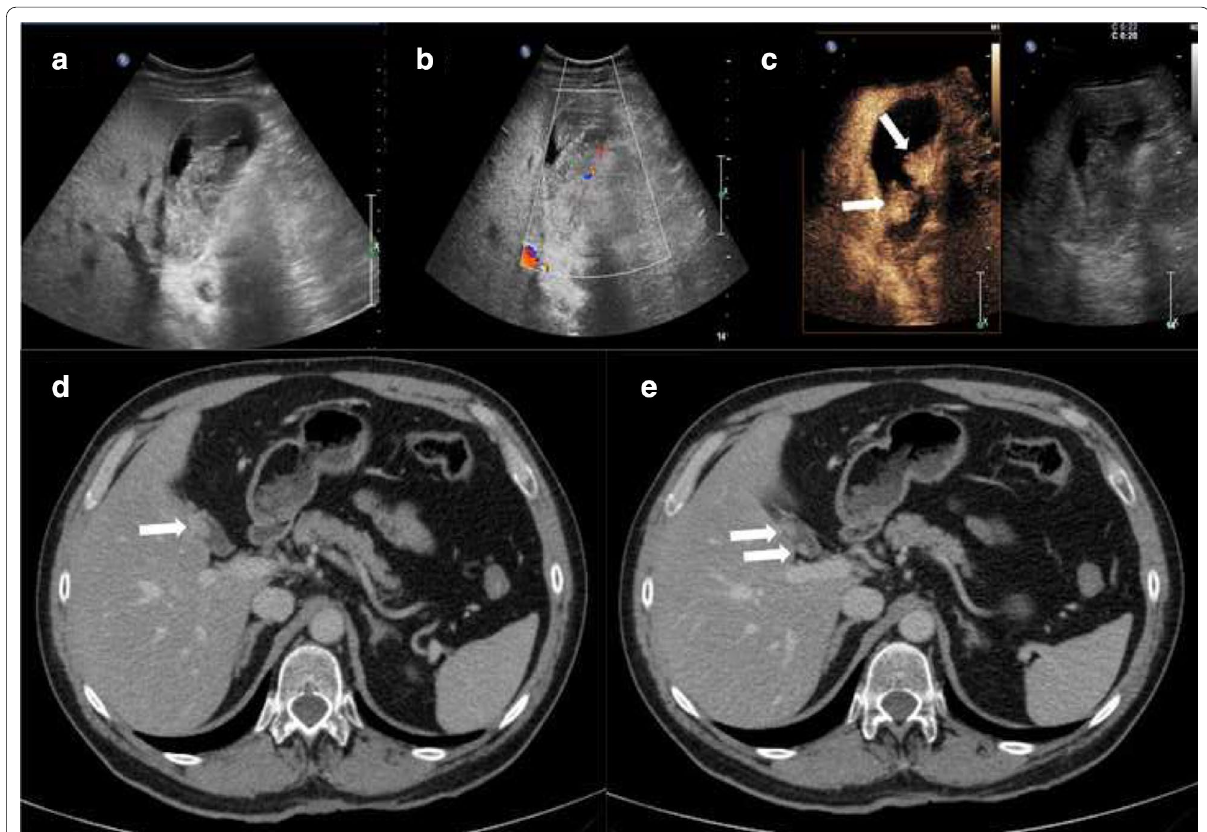
Fig. 1 A 56-year-old male hospitalized for right upper abdominal pain with nausea and vomiting. The pain was irradiated to the right scapular region. His medical history included a total excision of dorsal melanoma 2 years before, with no evidence of metastatic disease at the primary staging. The B-mode US ( a ) showed the gallbladder lumen completely filled with heterogeneous content which was difficult to differentiate between tumefactive biliary sludge and parietal mass. The corresponding color-doppler ( b ) revealed no vascular signal within the endoluminal content. CEUS ( c ) demonstrated the vascularization of 2 polypoid lesions (arrows) protruding into the gallbladder lumen with intense contrast enhancement in the arterial phase (20 s). The portal venous phase CT images ( d , e ) confirmed two enhancing mural nodules (arrows) of galbladder wall that were histologically proved to be metastases from